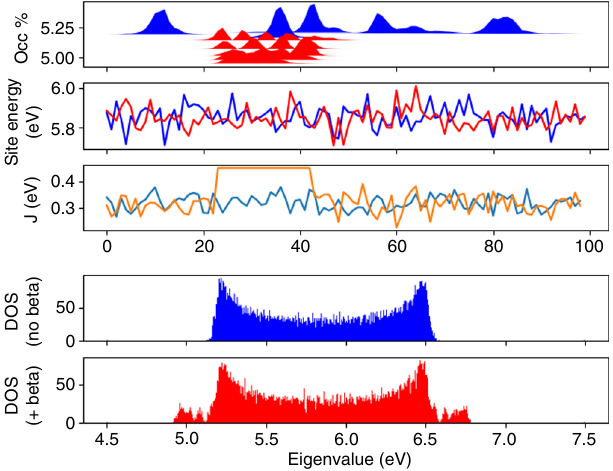
FIG. 7. Top panel: Probability density (i.e., j ψ j 2 ) for the lowest five eigenfunctions ψ for an energetically and torsionally dis- ordered β -phase free 100-mer chain (blue), and a disordered chain containing a 20-mer of β -phase (red), with the energetic disorder width 0.05 eV and the torsional disorder width 0.1 radians. Note that the lowest eigenfunctions for the system containing the β -phase segment are localized in the planarized segment. Second panel: Site HOMO energies for the disordered β -phase free (blue) and β -phase embedded (red) chains. Third panel: Intersite (intermonomer) electronic couplings for the disordered β -phase free (light blue) and β -phase embedded (orange) chains. The x axes of the first three panels present the spatial extent along the 100-mers. Fourth panel: Density of states obtained by summing over all eigenvalues for the disordered β -phase free chain (blue). Bottom panel: Density of states obtained by summing over all eigenvalues for the disordered β -phase embedded chain (red). The x axes of the bottom two panels present energy in units of